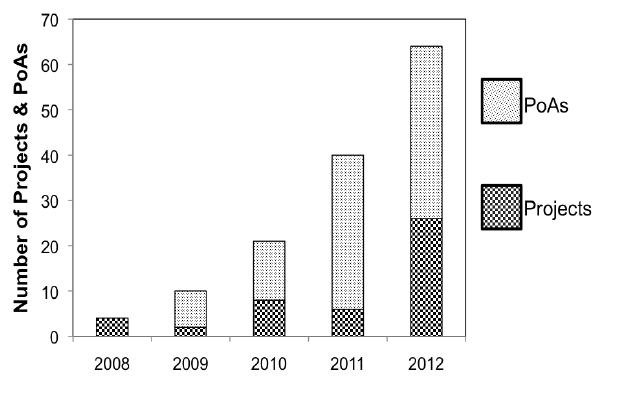
Figure 2. Number of CDM projects and